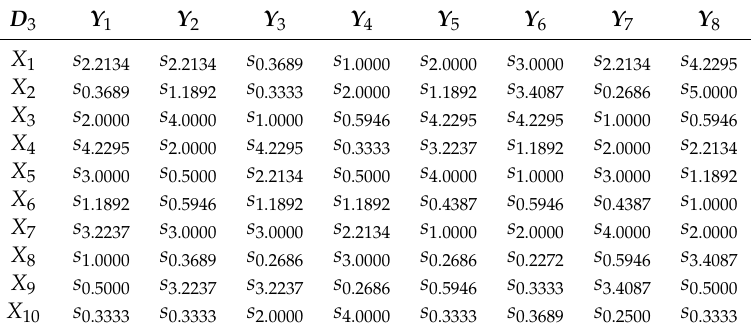
Table A8. Deterministic linguistic evaluation information matrix of D 3 .